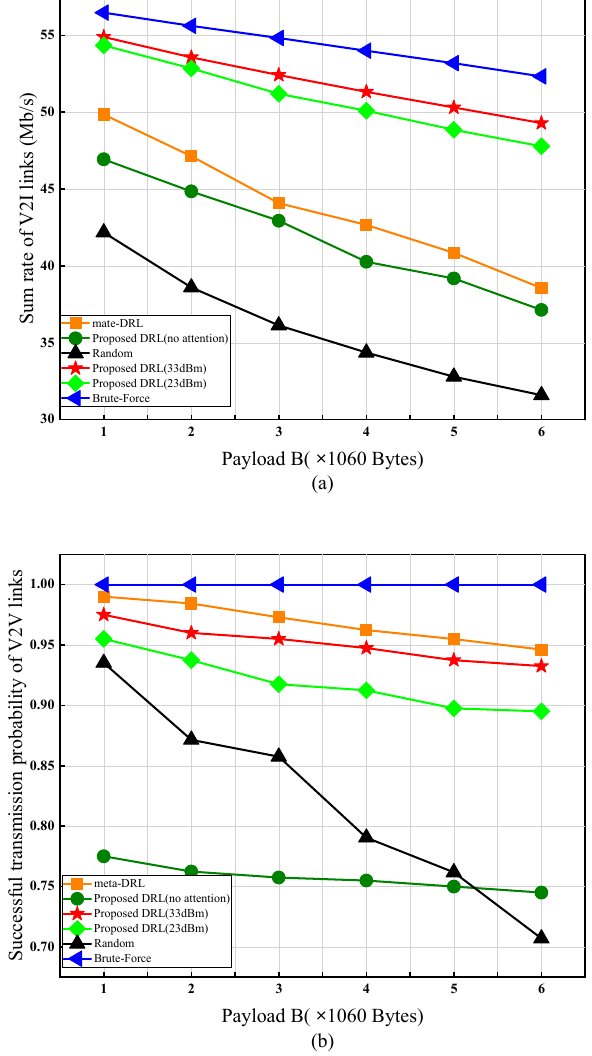
Figure 5. The performance for different payload sizes: ( a ) Sum rate of V2I links. ( b ) Successful transmission probability of V2V links.